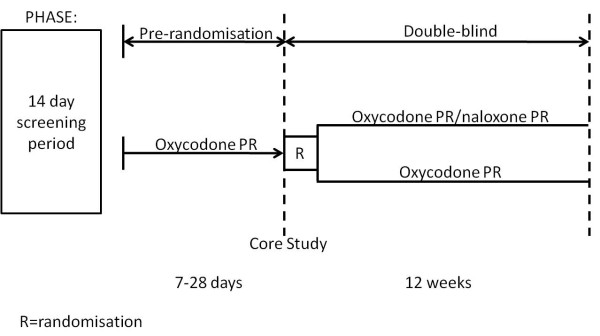
Study design. PR = prolonged-release.